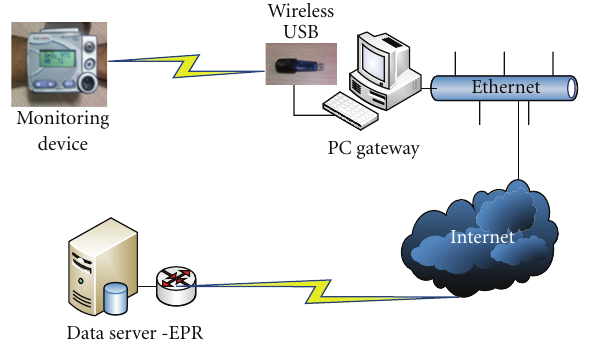
Figure 2: The system operation